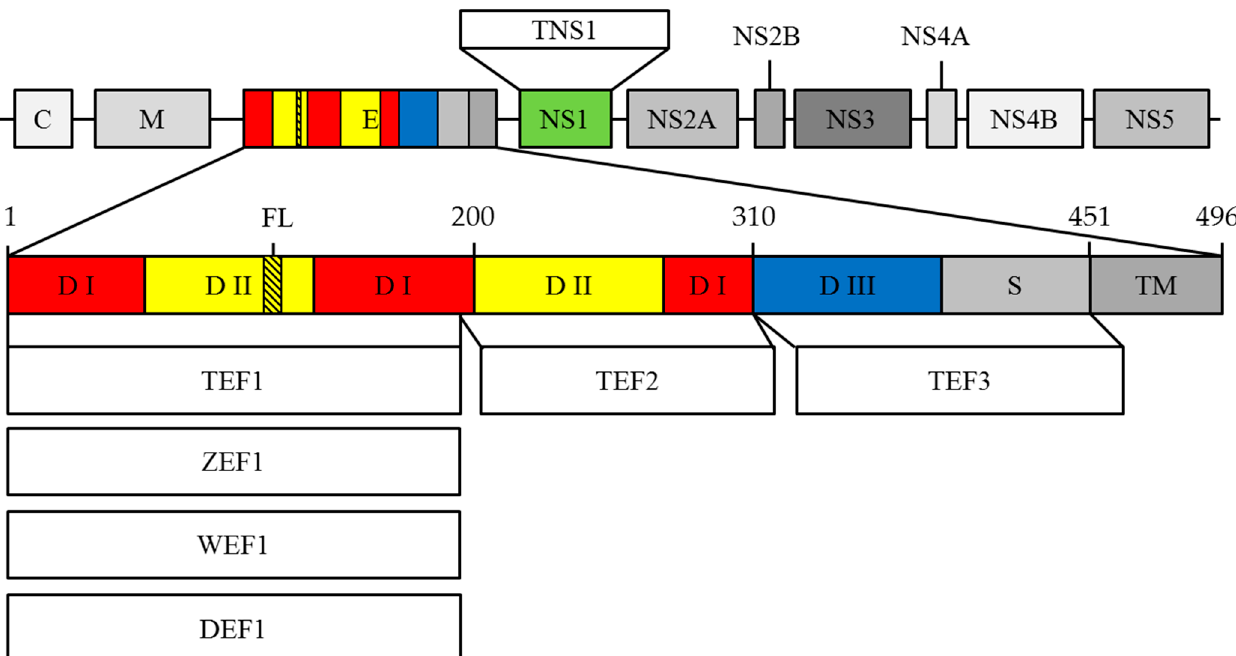
Figure 1. Schematic visualization of fragments polyprotein structure. C—capsid protein;